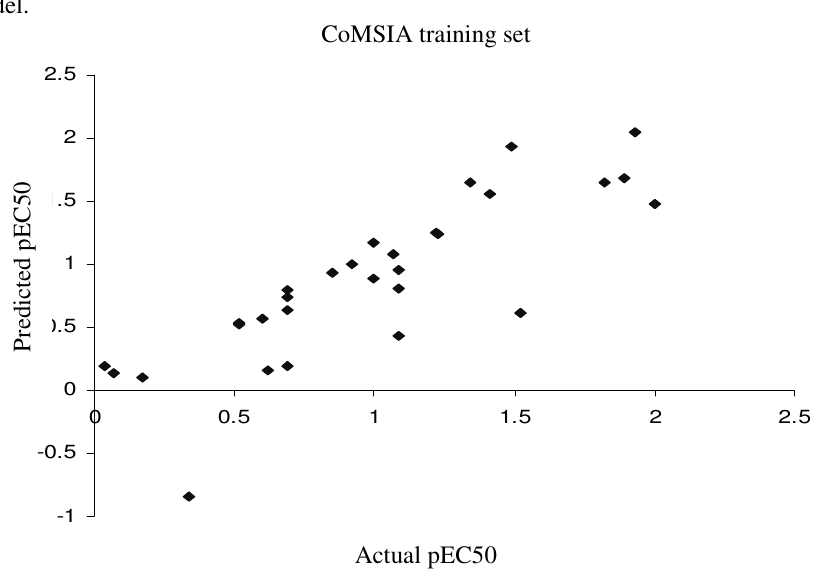
values of training set molecules for CoMFA 50